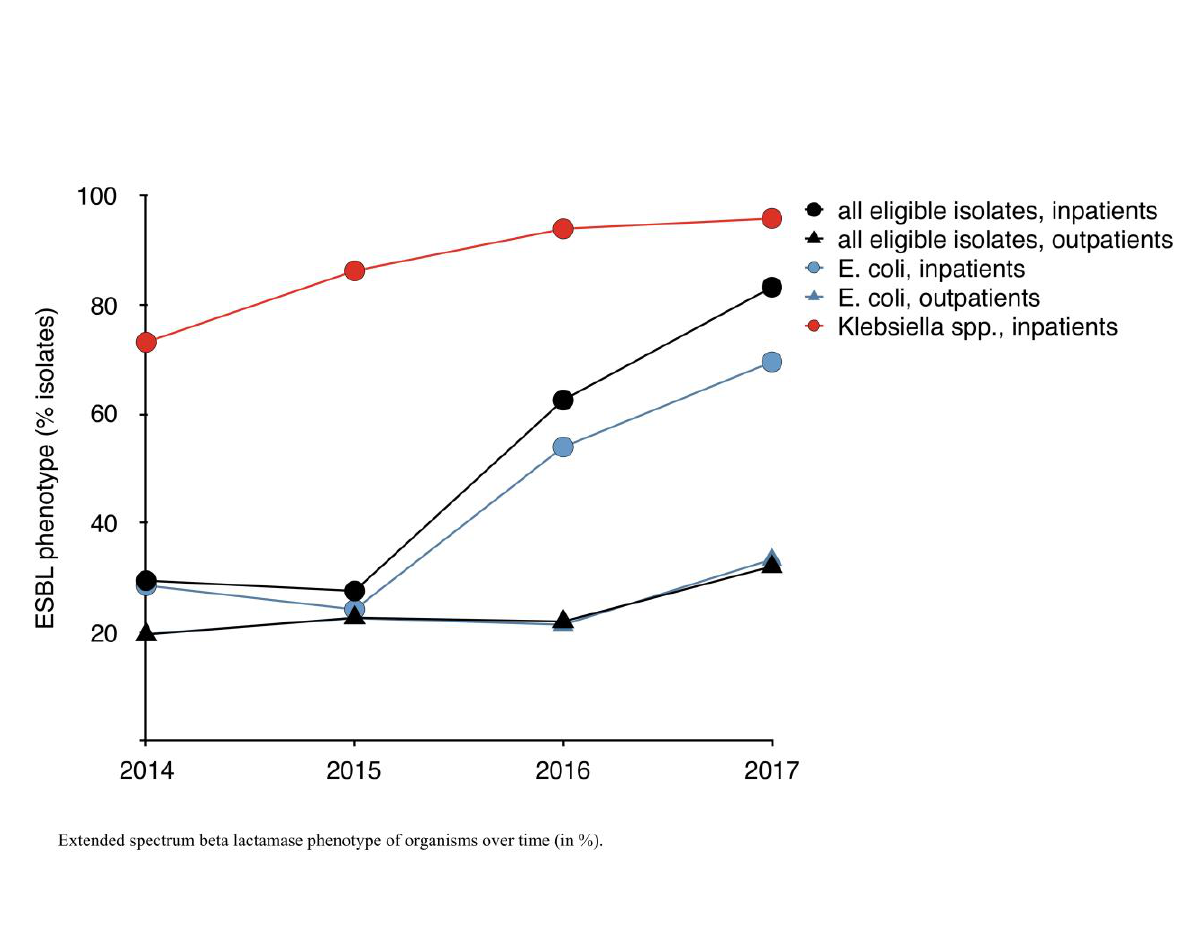
Figure 3. Extended spectrum beta lactamase phenotype of organisms over time (in